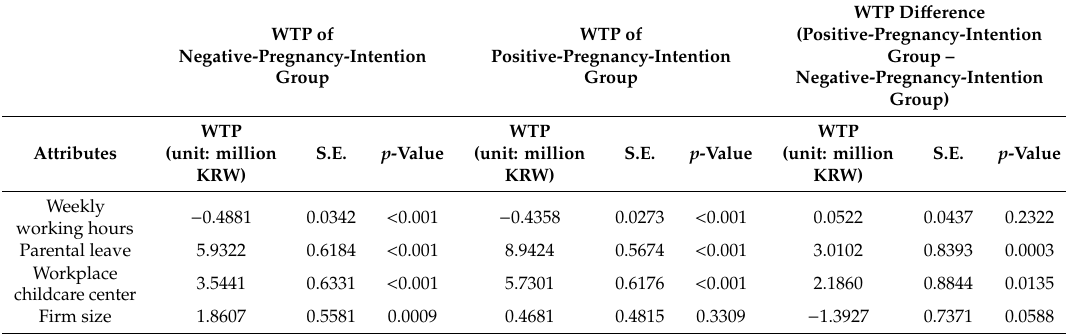
Table 14. WTP for workplace attributes, by pregnancy